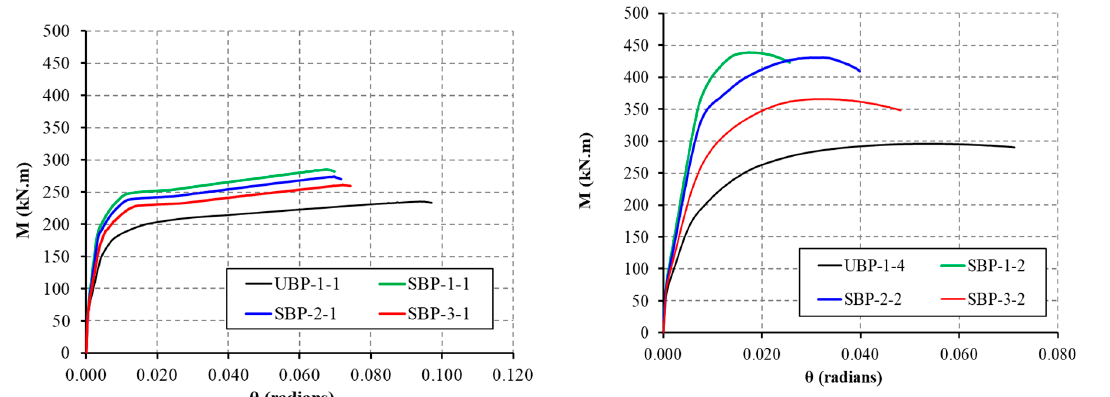
Figure 7. Influence of the sti ff ener